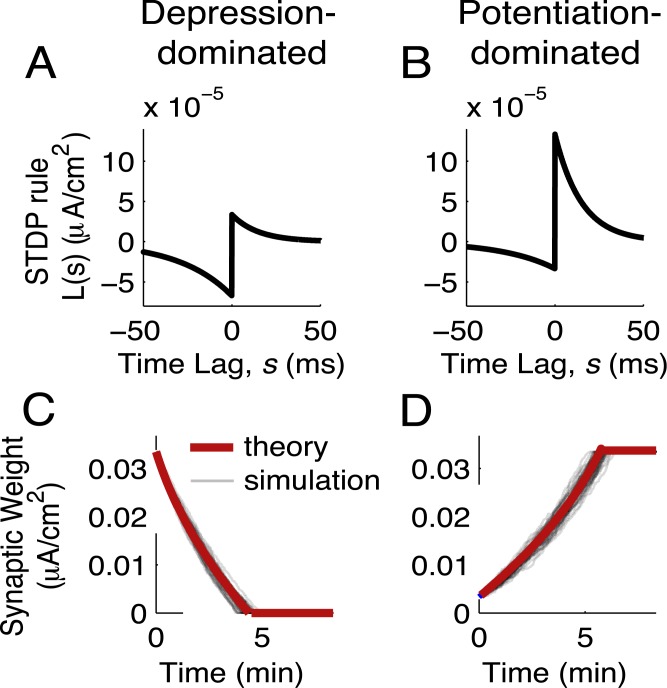
Unbalanced plasticity gives rise to simple weight dynamics.(A) Depression-dominated STDP rule: the amount of depression (integral of the depression side of the curve) is twice the amount of potentiation. (B) Potentiation-dominated STDP rule: the amount of potentiation is twice the amount of depression. (C) Evolution of synaptic weights with depression-dominated STDP: all weights depress. (D) Evolution of synaptic weights with potentiation-dominated STDP: all weights potentiate. Red lines: theory for mean synaptic weight. Shaded lines: simulation of individual synaptic weights.